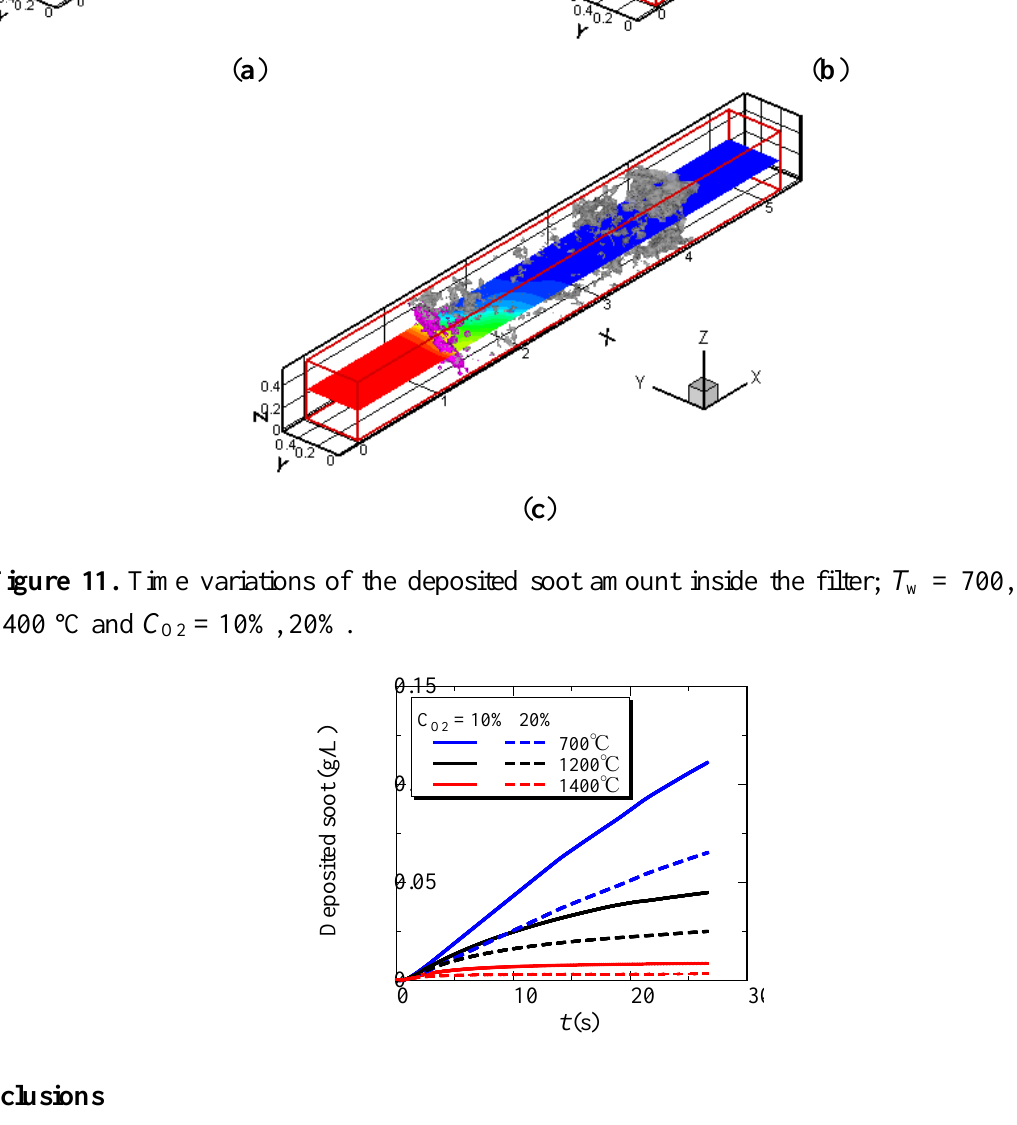
Figure 10. 3D distributions of deposited soot at C ( b ) T = 1200 °C; ( c ) T = 1400 °C. The purple contour corresponds to deposited soot. The w w profile in the x-y plane is the soot mass fraction in the gas phase.